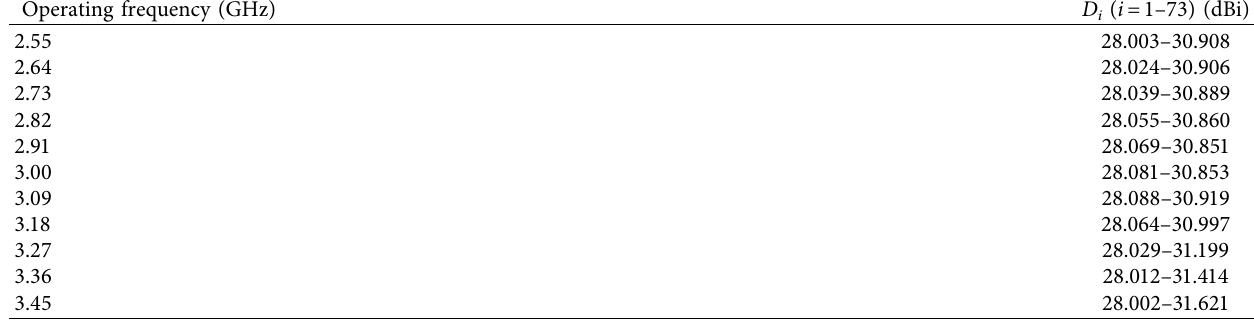
Figure 6: Far-field patterns of the obtained mesh-shaped reflector. (a) Operating frequency: 2.55GHz. (b) Operating frequency: 3.00GHz. (c) Operating frequency: 3.45GHz. Table 2: Far-field pattern results within the whole frequency band.